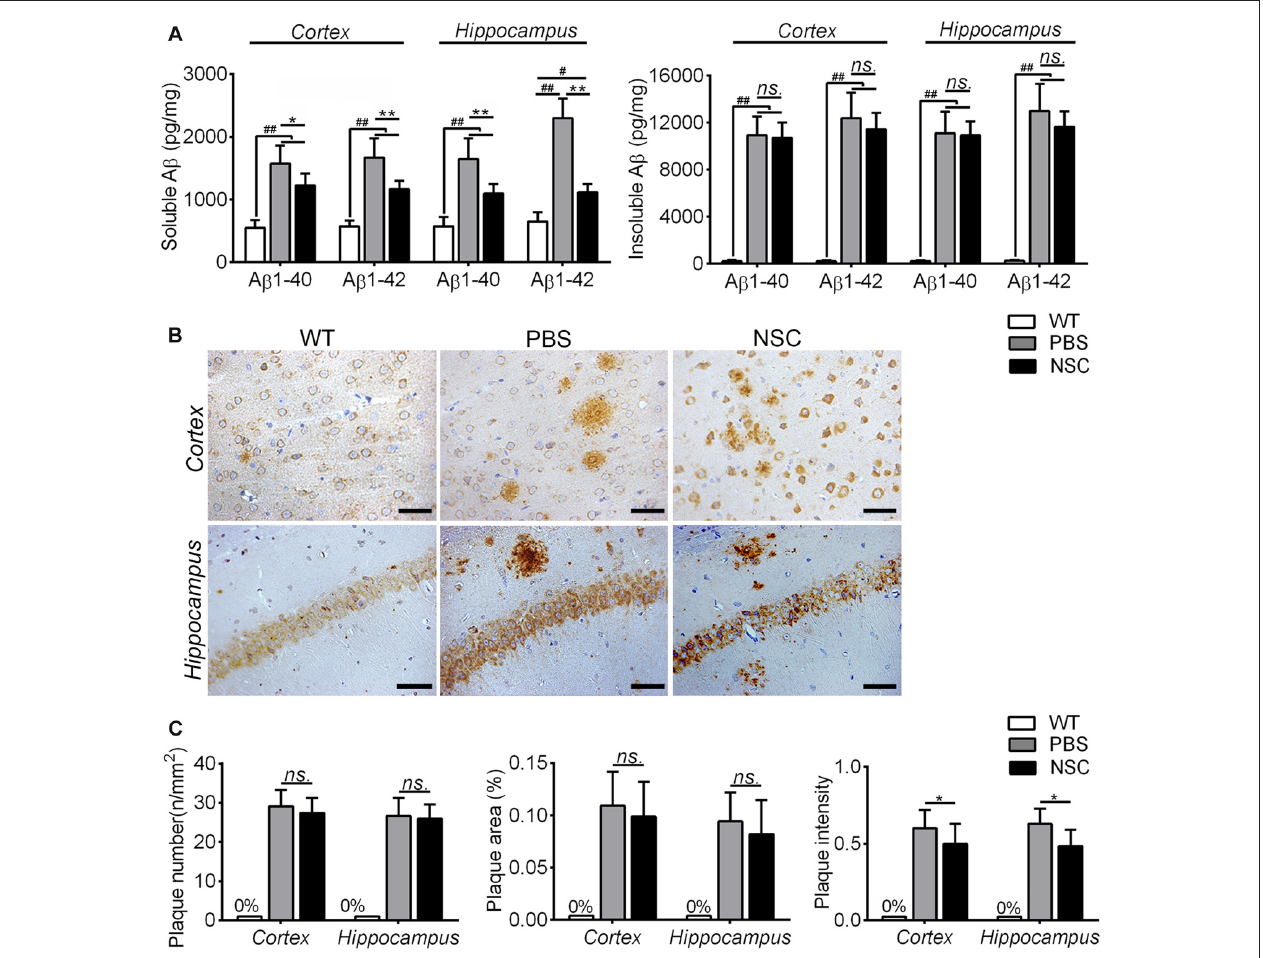
FIGURE 3 | hNSCs slightly alleviated A β pathology in APP/PS1 mice. (A) Analysis of ELISA results. The soluble and insoluble A β s were significantly higher in the frontal cortex and hippocampus of the PBS and NSC group than that of WT mice ( # p < 0.05; ## p < 0.01 vs. WT mice). Though soluble A β s was significantly reduced in the NSC group ( ∗ p < 0.05; ∗∗ p < 0.01 vs. the PBS group), no significant difference was found in insoluble A β s between the NSC and PBS group ( ns. = p > 0.05). (B) Representative 6E10-staining images in the cortex and hippocampus of PBS, NSC group and WT mice. Scale bar: 20 µ m. (C) There were